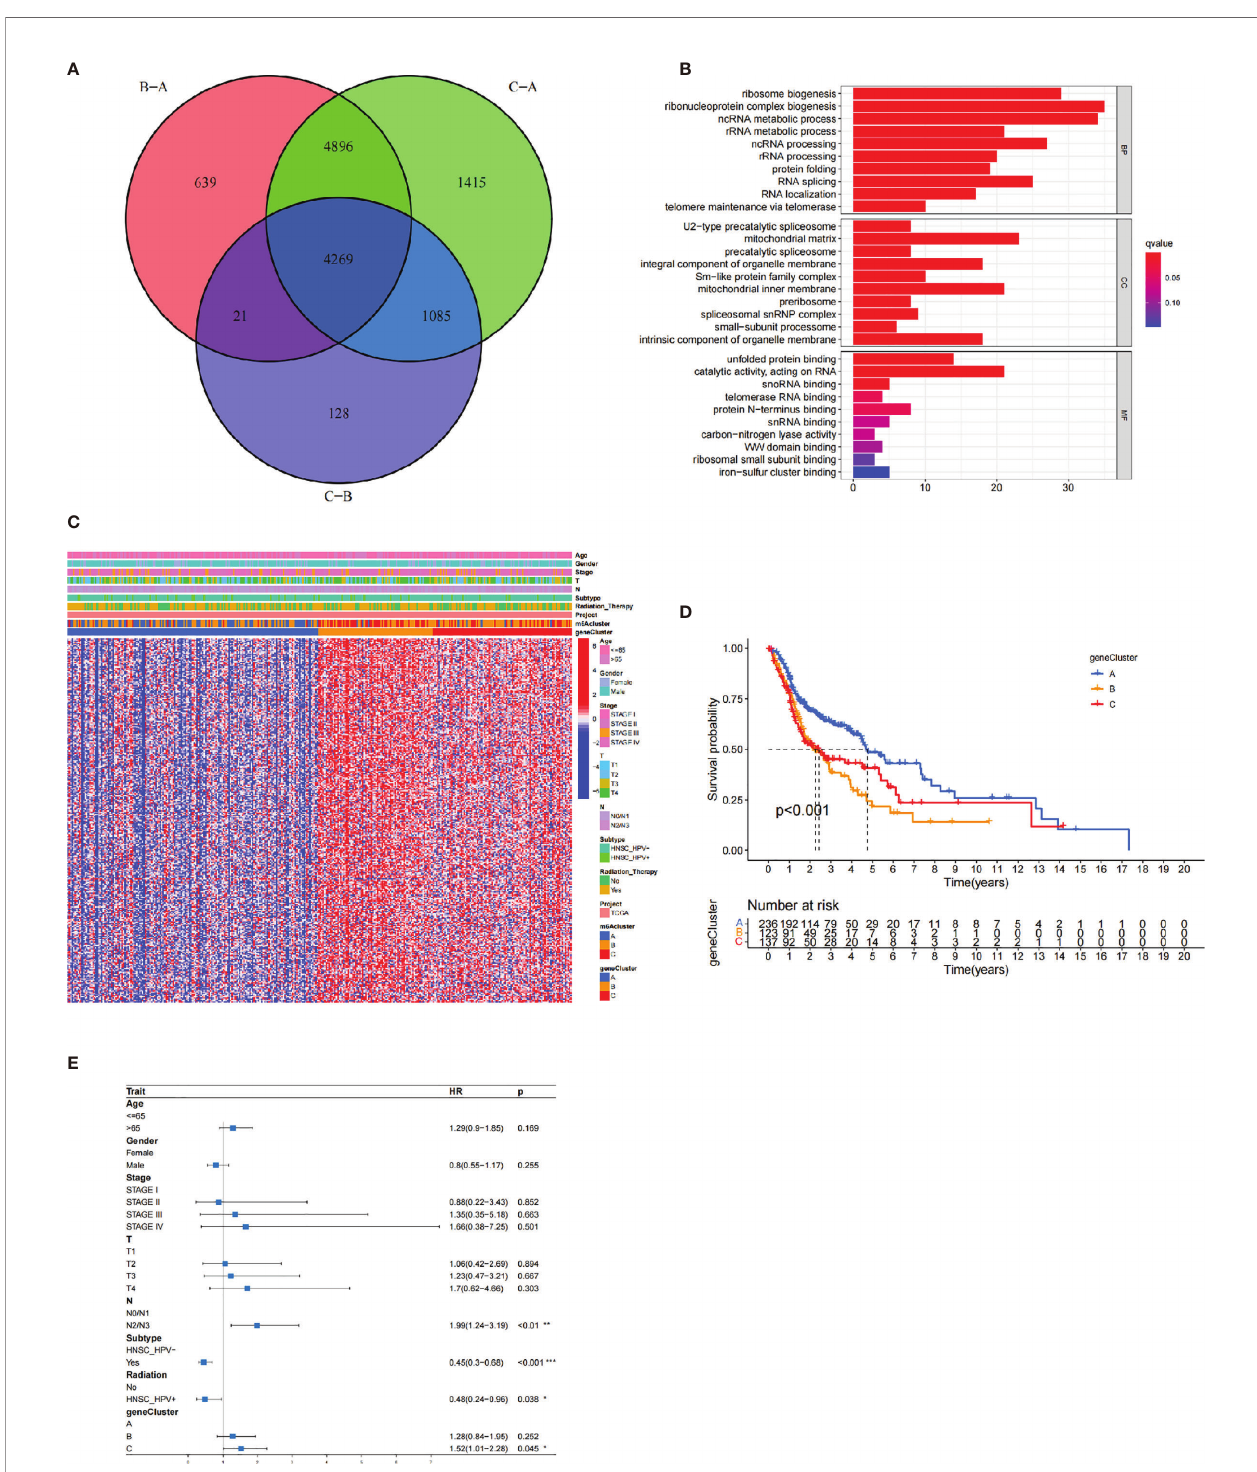
FIGURE 4 | The construction of m 6 A gene clusters and functional annotation. The 4,269 differentially expressed genes (DEGs) among three m 6 A clusters were shown in the Venn plot. (B) GO enrichment analysis of 311 prognosis-related DEGs. (C) The consensus clustering based on prognosis-related DEGs classi fi ed patients into three gene clusters, respectively. (D) The Kaplan-Meier curves of the three m 6 A gene clusters ( p < 0.001). (E) The multivariate Cox regression-estimated prognostic value of m 6 A gene clusters in TCGA